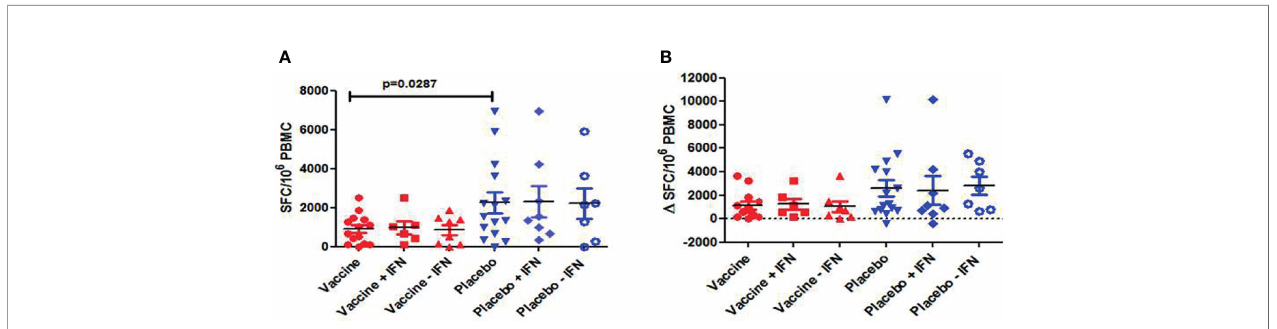
FIGURE 6 | Total HIV-1 speci fi c T cell responses measured by IFN- g ELISPOT: (A) Individual responses and mean ± SEM of SFC/106 PBMC for the different arms of the study at w0 (baseline); (B) Changes of HIV-1-speci fi c T cell responses at w16 for the different arms of the study [ D SFC/106 PBMC (w16-w0)]. No signi fi cant differences were observed between vaccine and placebo groups (p=0.09). No effect on HIV-1-speci fi c T cell responses was observed with the administration of IFN.